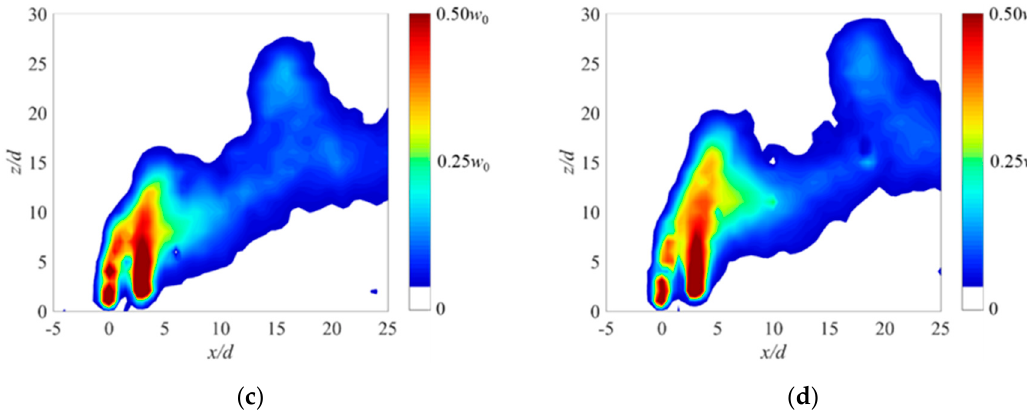
Figure 5. Phase-averaged vertical velocity distributions of the jet in Case A3 at four typical wave phases: ( a ) t / T = 0, wave crest; ( b ) t / T = 1/4, down-zero crossing; ( c ) t / T = 1/2, wave trough; ( d ) t / T = 3/4, up-zero crossing.